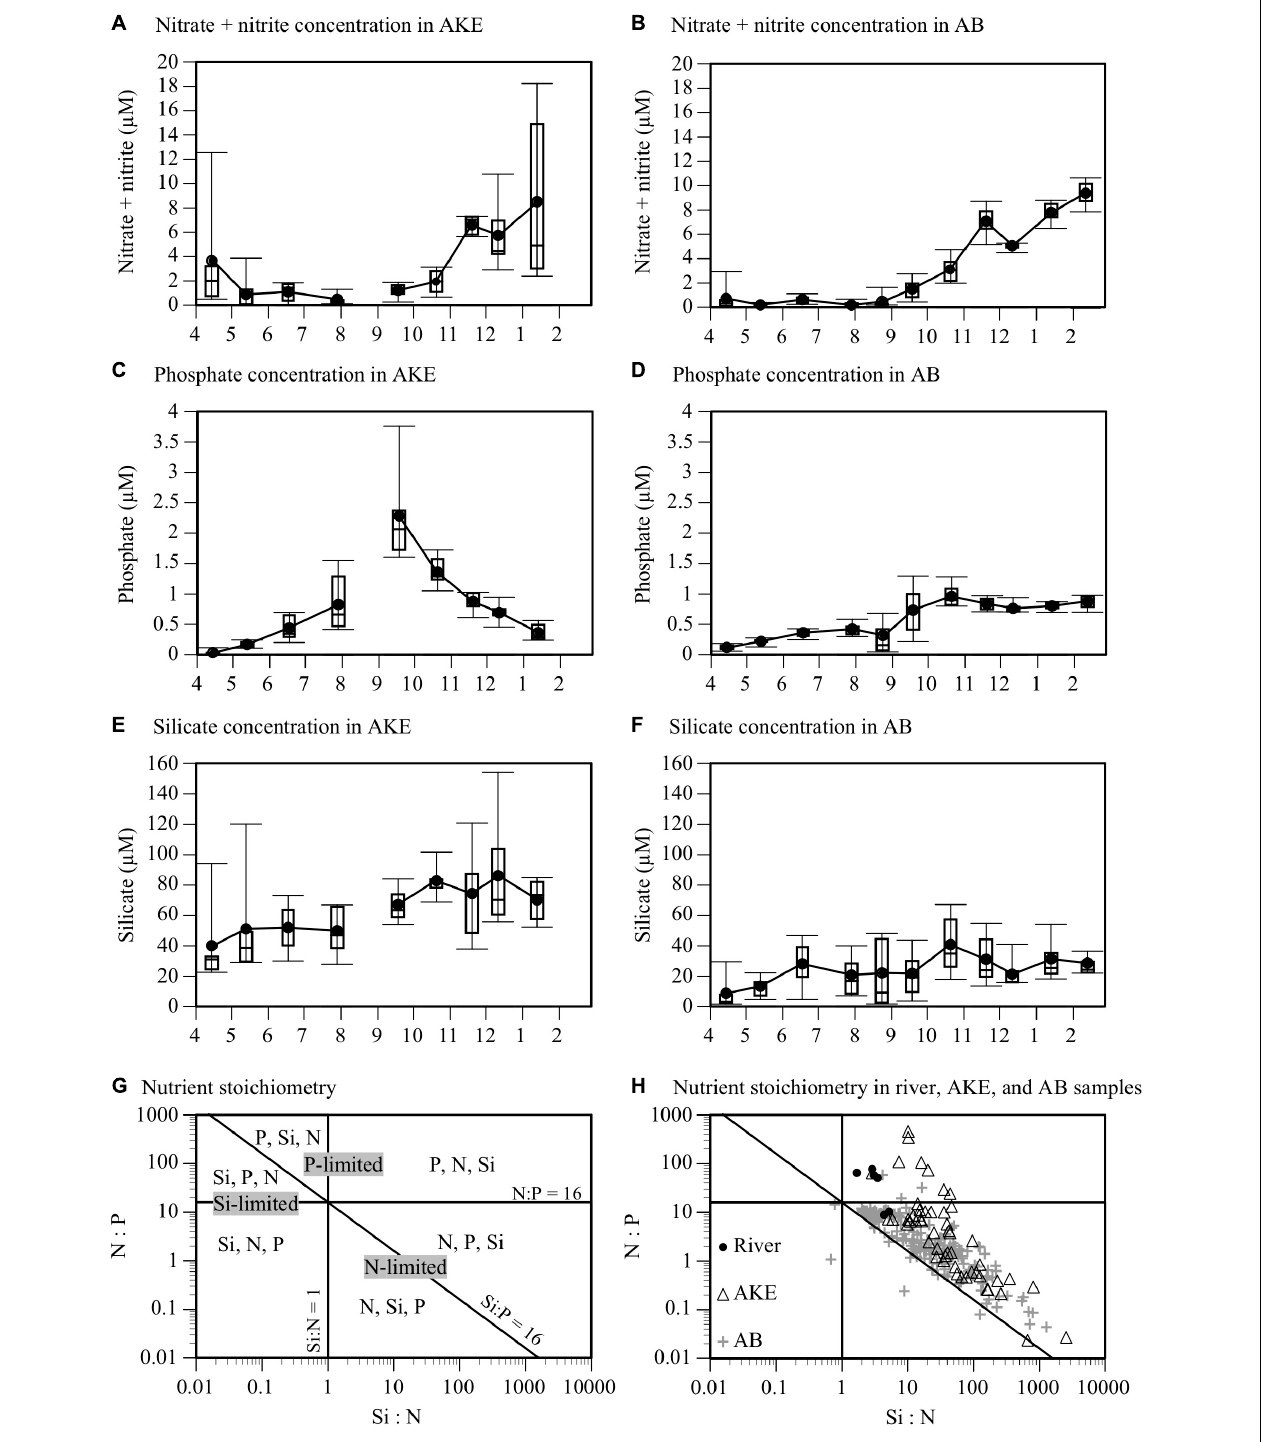
FIGURE 3 | Time-series box plots of (A,B) nitrate plus nitrite, (C,D) phosphate, and (E,F) silicate concentrations in AKE and AB from April 2014 to February 2015. Rectangles, horizontal lines in boxes, black closed circles, and I-bars represent inter-quartile ranges, medians, means, and minimum and maximum values, respectively, except for outliers exceeding 1.5 times the interquartile range. (G) Synthetic graph of the N:P:Si nutrient stoichiometric ratio. The vertical (Si:N), horizontal (N:P), and diagonal (Si:P) lines and each area delimited by the lines represent the Redfield ratio (N:P:Si = 16:1:16) and the potential limiting nutrients. Nutrients are given in the order of their limitations for each area determined by the Redfield ratio. (H) Scatter plot of N:P:Si ratio at the surface in rivers, AKE, and AB from April 2014 to February 2015.